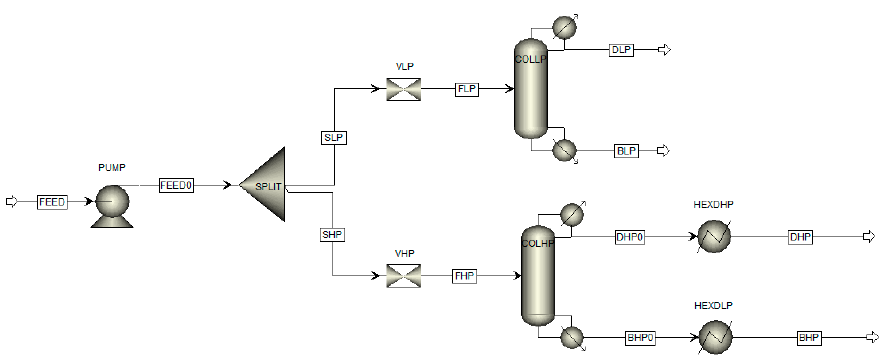
Figure 3. Schematic representation of the EHIDDiC model in Aspen Plus ® [50].